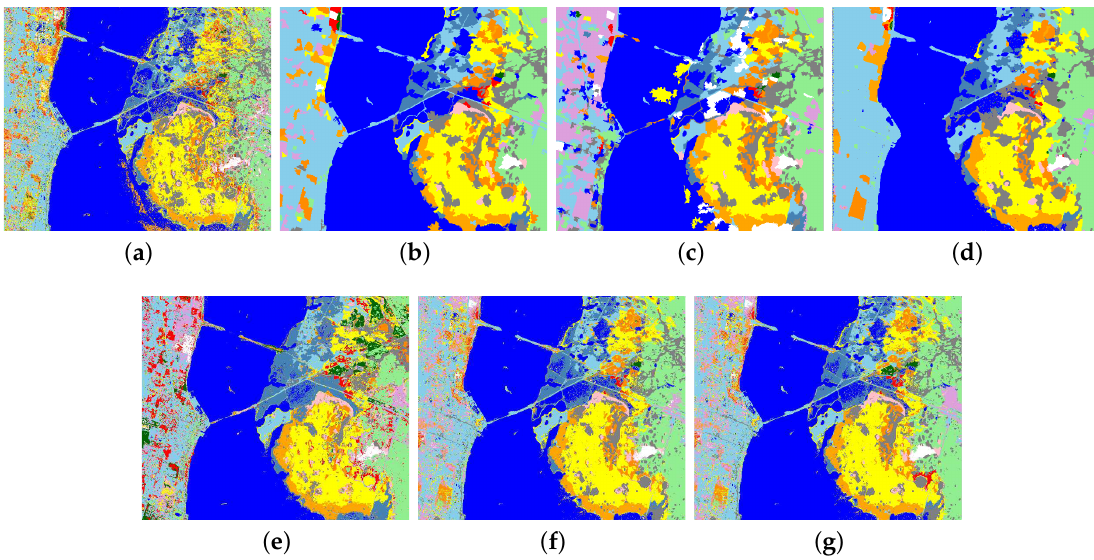
Figure 7. Classification maps and overall classification accuracies (in parentheses) obtained for the AVIRIS Kennedy Space Center dataset using different classification methods. ( a ) KSRC (89.86), ( b ) MV (93.30), ( c ) KJSRC (92.96), ( d ) CRF (93.49), ( e ) CKEMAP (97.43), ( f ) SSG (92.98), ( g ) SSGL (98.56).